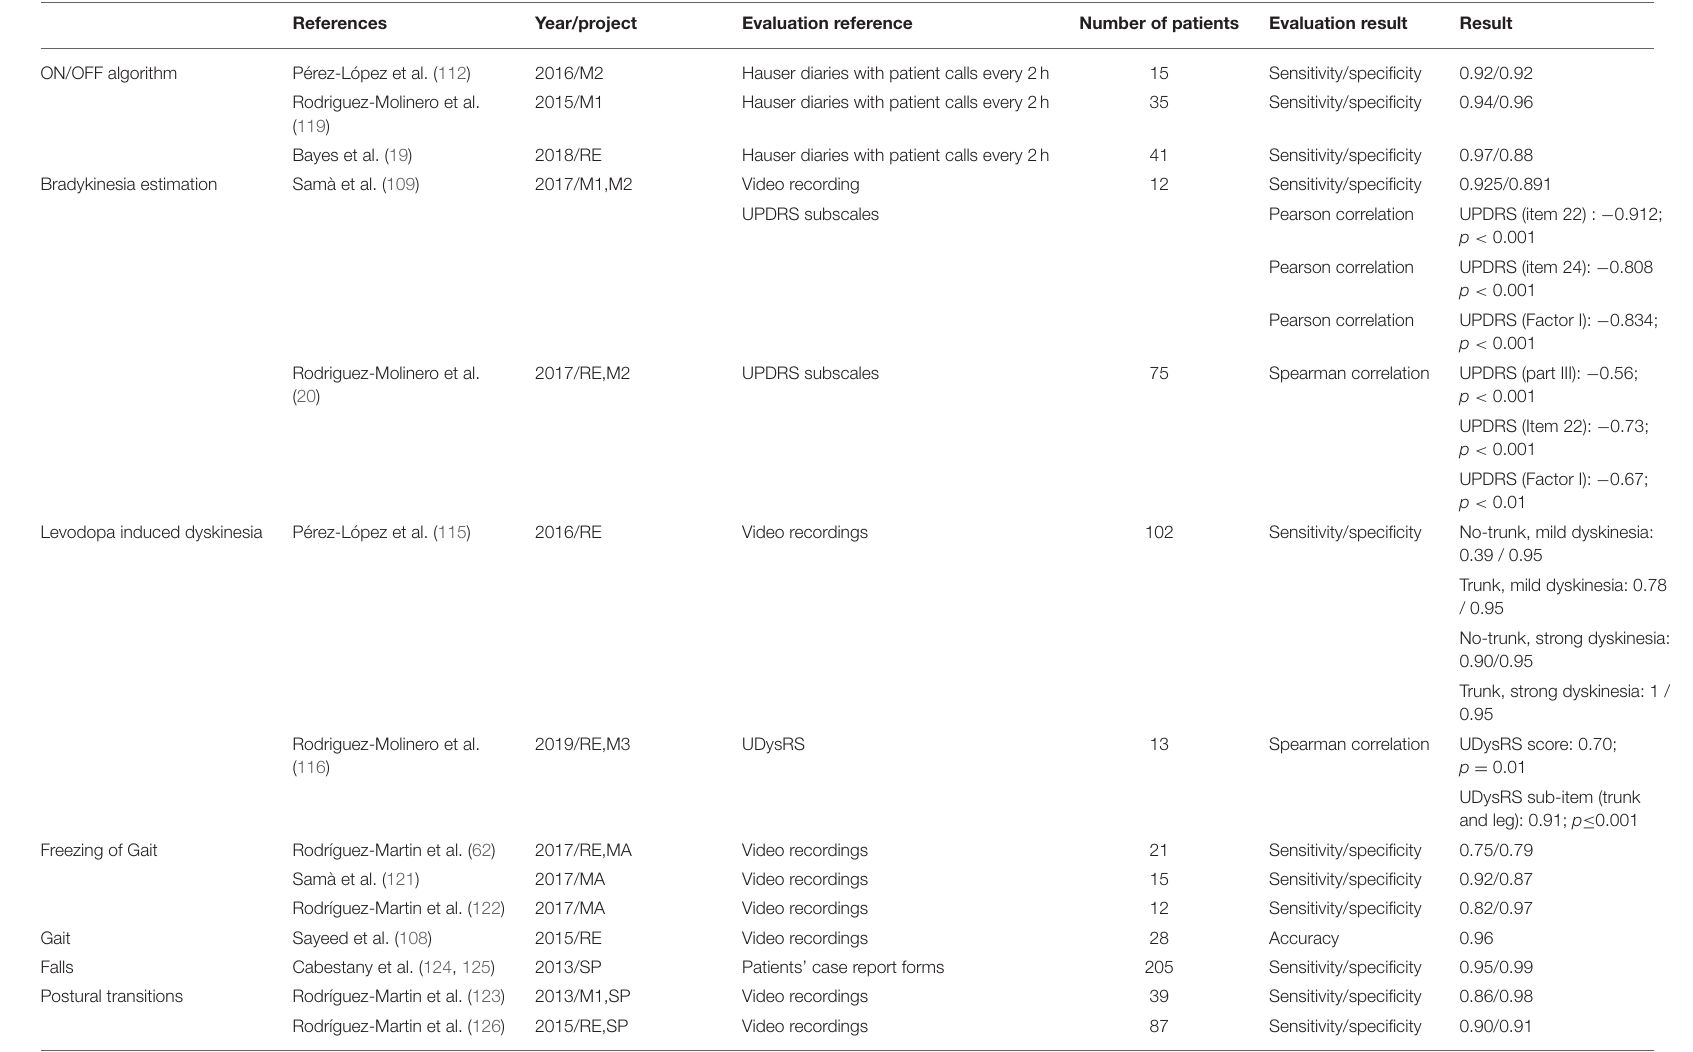
TABLE 2 | A summary of the main results obtained in the included